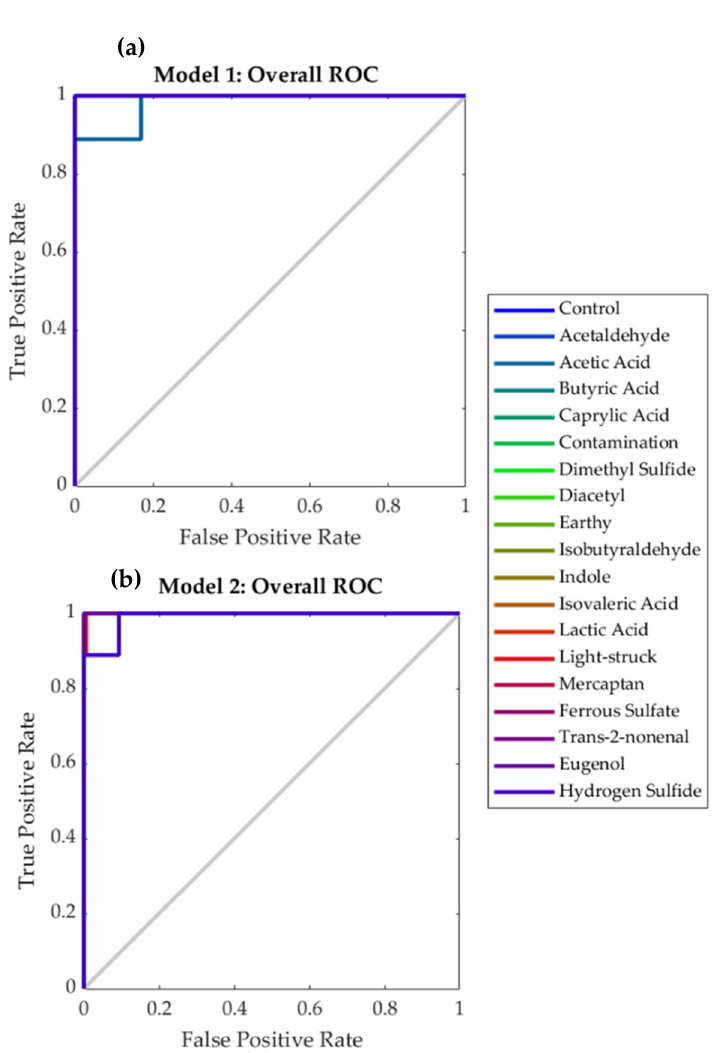
Figure 8. Receiver operating characteristic (ROC) curves of the ( a ) low (Model 3) and ( b ) high (Model 4) concentration samples to classify beers according to the faults present in them using the near-infrared absorbance values as